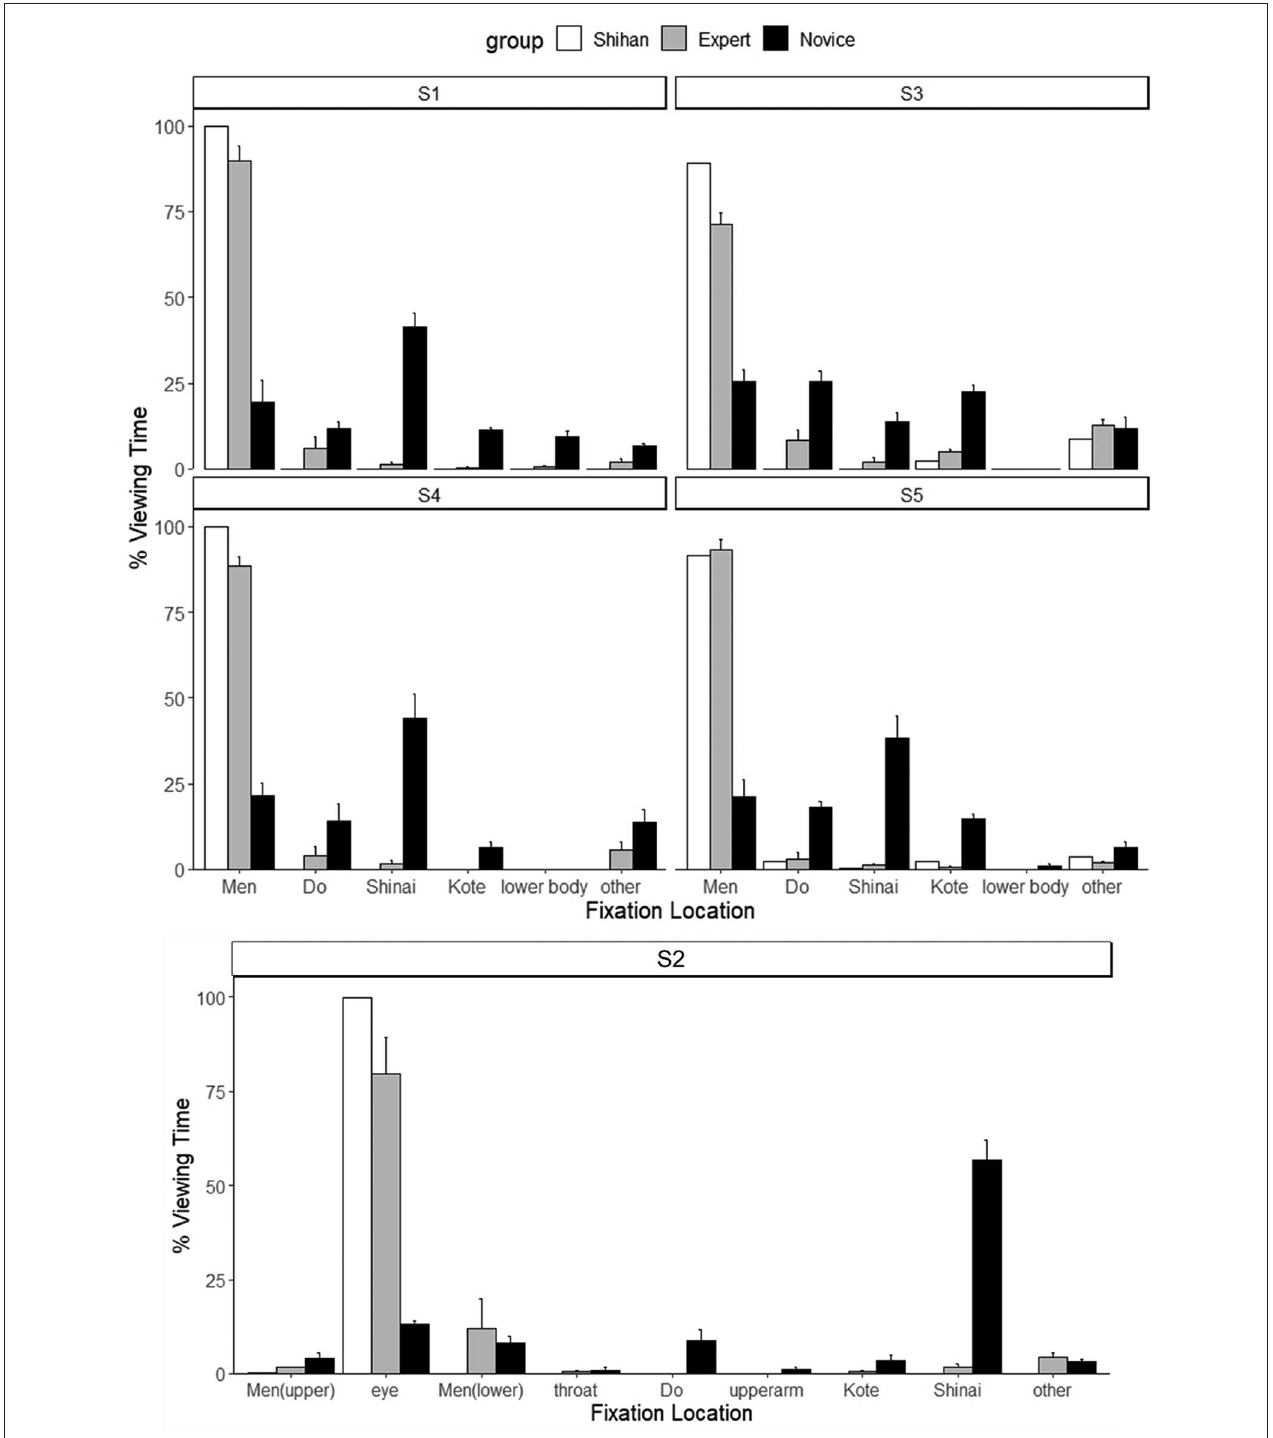
FIGURE 4 | Mean (SD) percentage viewing time per fixation location which is categorized in Figure 3